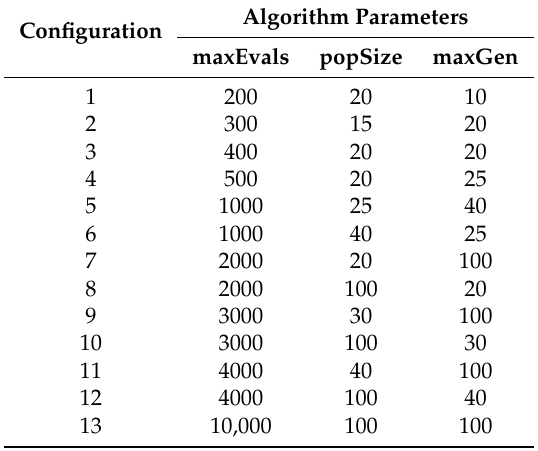
Table 3. Parameter settings used in different runs of the competing